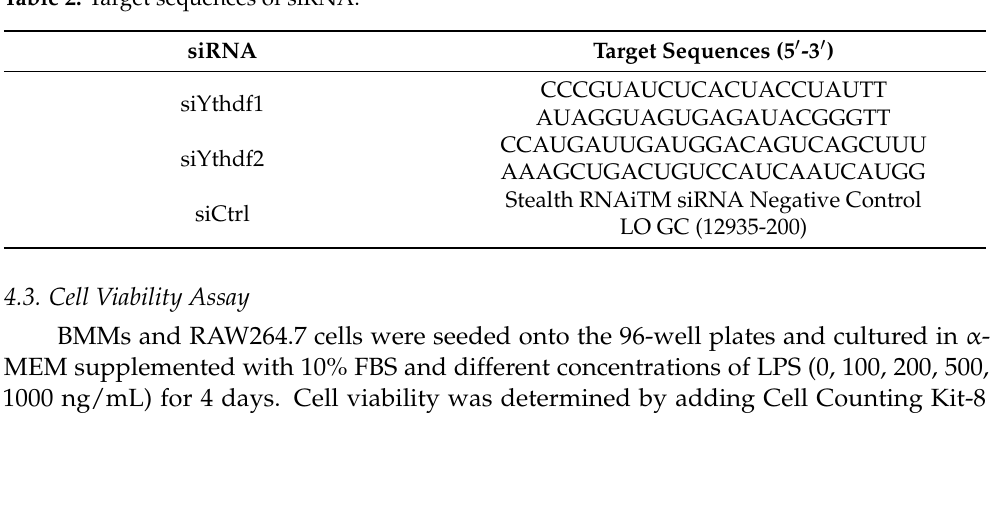
Table 2. Target sequences of